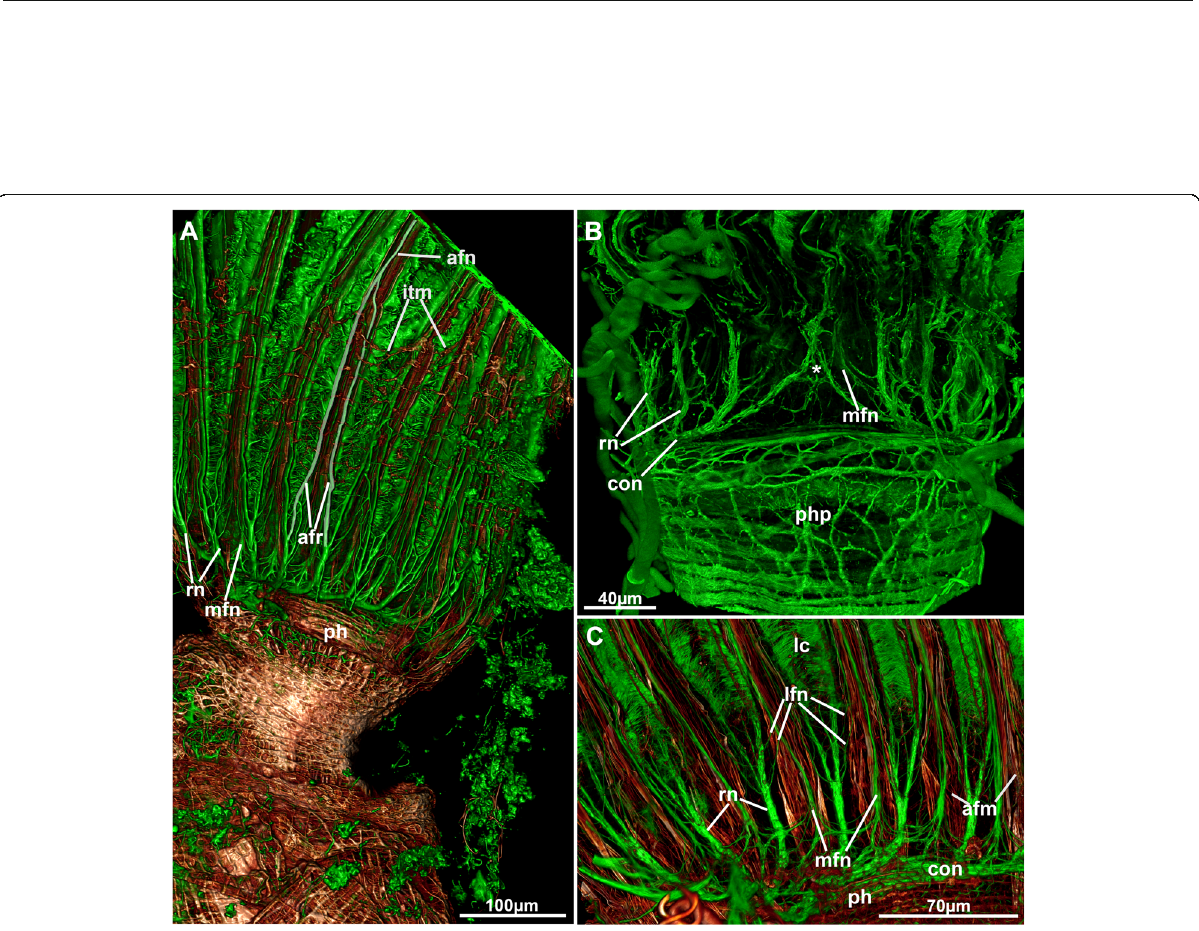
Fig. 18 Overview of the lophophoral nervous system of Stephanella hina . Confocal laser scanning microscopy stacks based on acetylated alpha- tubulin labelling. Volume renderings. Acetylated alpha-tubulin in green LUT, f-actin in glow LUT. a Volume rendering showing an overview of the lophophoral nervous system. One of the abfrontal neurite bundles and its roots have been highlighted in white. b Oral view of the circum-oral nerve ring closing medially on the oral side (asterisk). c Close-up of the lophophoral base showing radial nerves and their position with respect to the abfrontal tentacle muscle bands. Abbreviations: afm – abfrontal muscle band, afn – abfrontal neurite bundle, afr – abfrontal neurite bundle root, con – circum-oral nerve ring, itm – distal border of the intertentacular membrane, lc – lateral cilia, lfn - latero-frontal neurites, mfn – medio- frontal neurite bundle, ph – pharynx, php – pharyngeal plexus, rn – radial